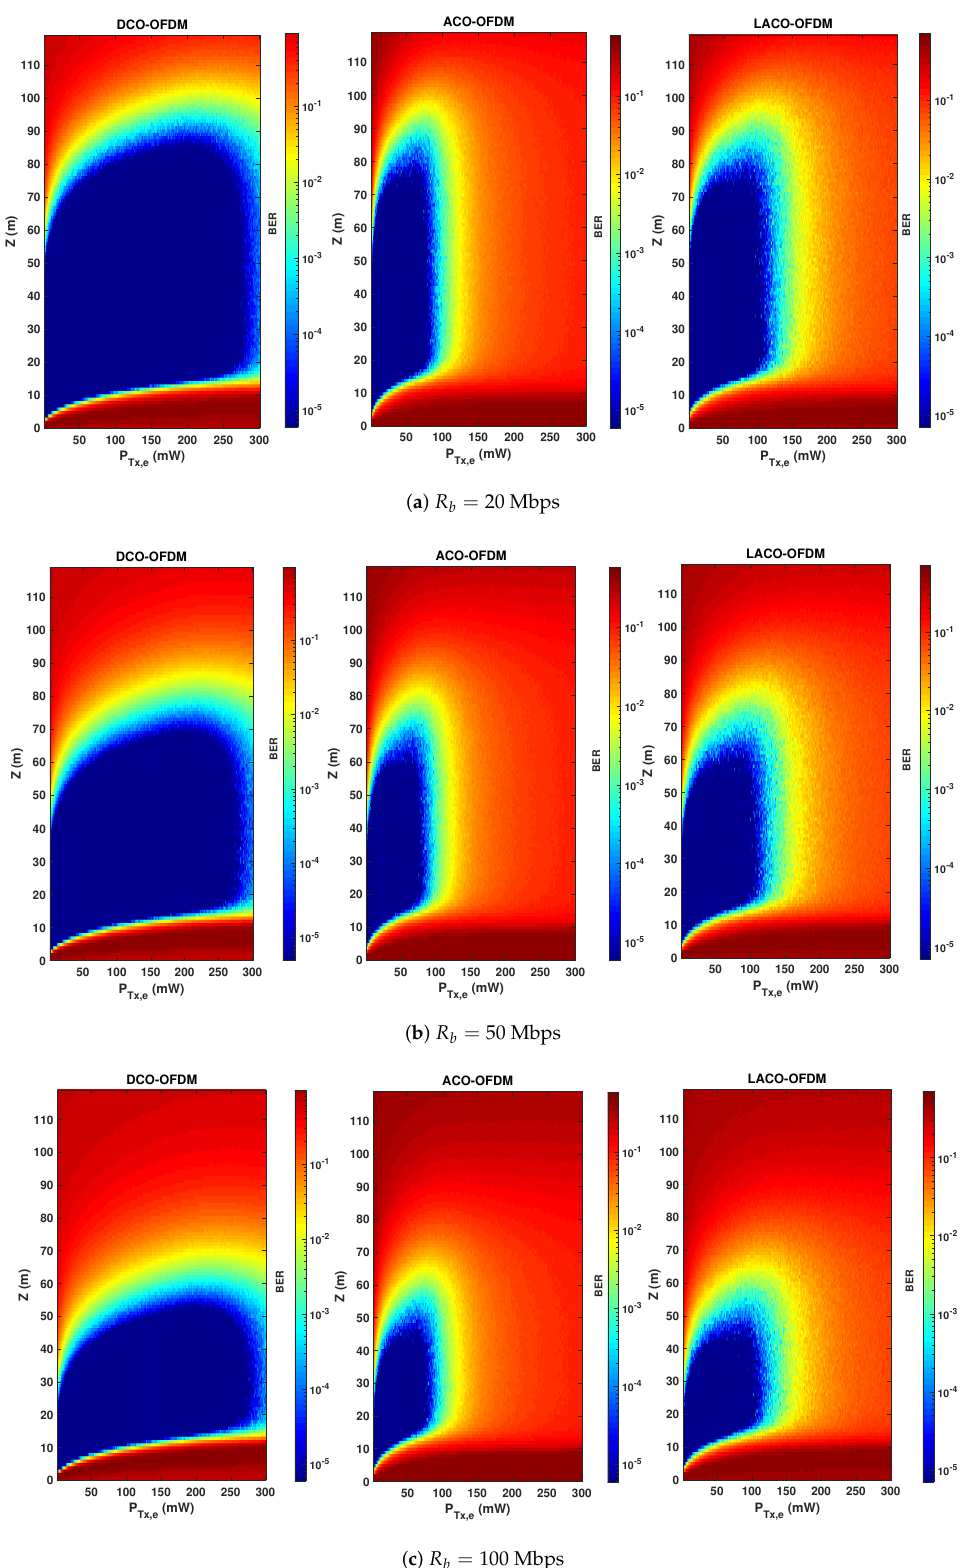
Figure 7. Comparison of BER performance versus the link range Z and the transmit electrical power P Tx,e of the three transmission schemes taking into account the LED DR and signal clipping. N = 1024, N CP = 9, 20, and 28, for data rates of ( a ) 20, ( b ) 50, and ( c ) 100Mbps, η ≈